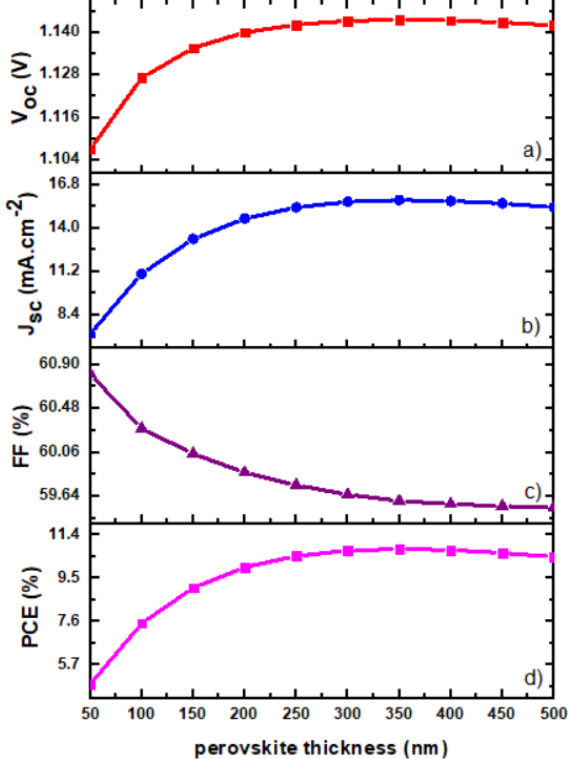
Figure 10. Effect of thickness of the perovskite absorber layer on the solar cell. parameters.